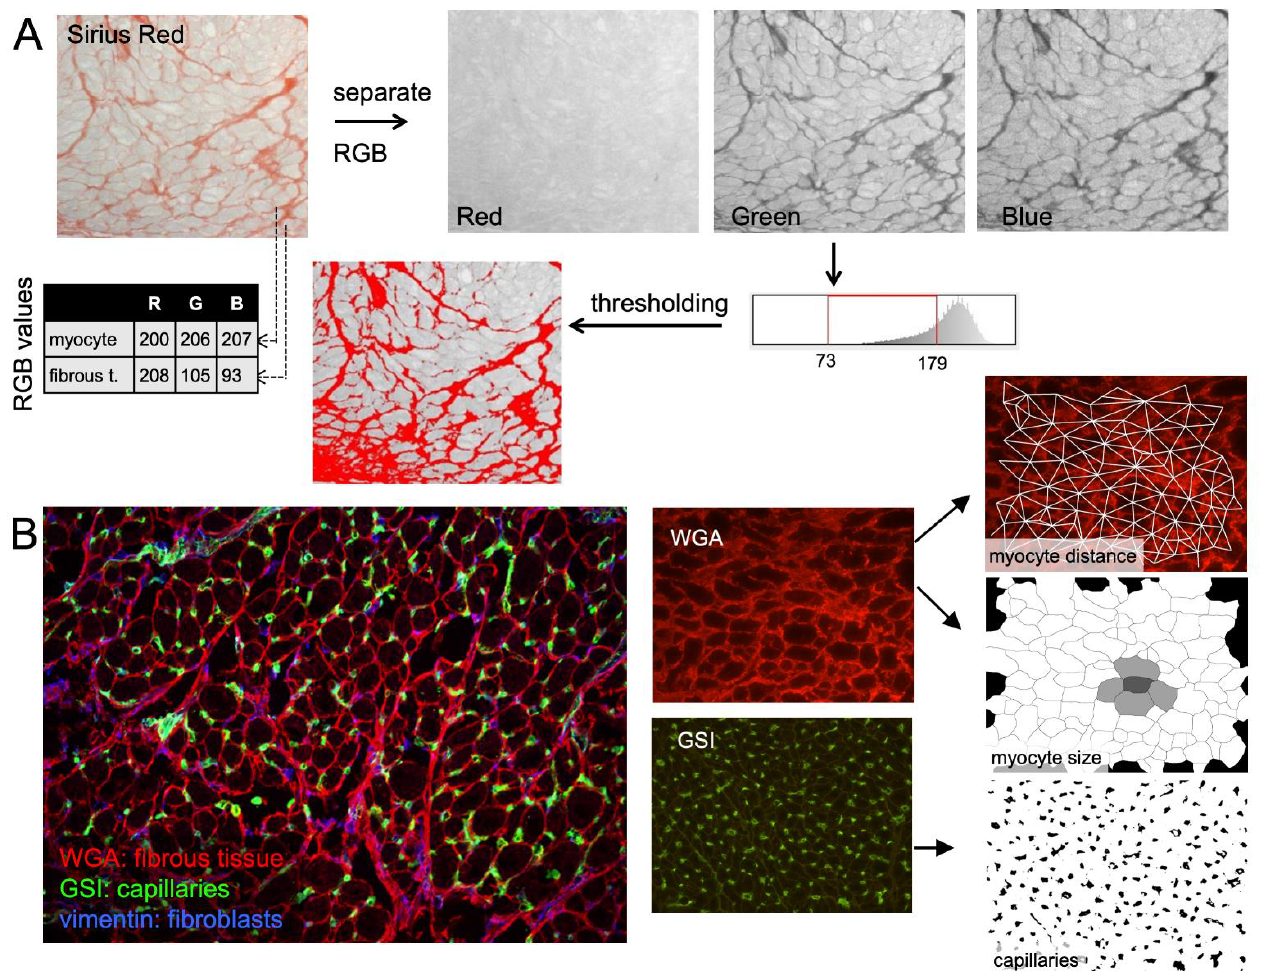
Figure 7. Histological quantification of fibrosis. ( A ) Sirius Red staining of goat atrial tissue: fibrous tissue is stained red, myocytes light green. Analysis of local red – green – blue (RGB) values illustrate significant overlap: the red value of myocytes is similar to that of fibrous tissue, although the green value of fibrous tissue is lower, allowing separation based on a user-defined threshold of the green image. However, endomysial fibrous tissue is poorly resolved, and the separation is sensitive to inhomogeneous illumination (relatively dark area at bottom left). ( B ) Fluorescent labelling of goat atrial tissue using wheat germ agglutinin (WGA, extracellular matrix in red), Griffonia Simplicfolia I (GSI, endothelial cells in green) and anti-vimentin antibody (fibroblasts in blue). Color-separated images allow automated thresholding, followed by quantification of endomysial fibrosis (myocyte-to-myocyte distance), overall fibrosis (percentage of red pixels), and myocyte size (short axes of dark areas). The structure of the extracellular matrix can then be correlated to other markers, e.g., the distribution of capillaries. Adapted from [108].